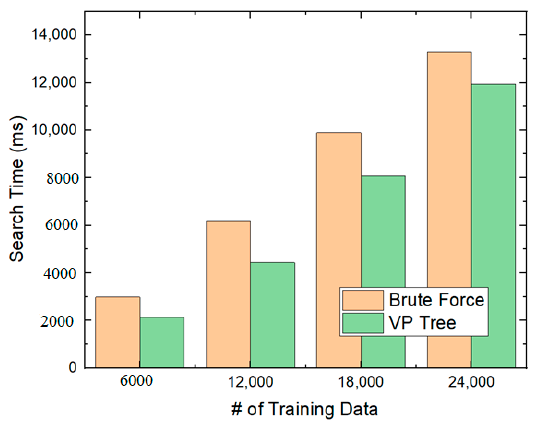
Figure 14. Search times. Figure 14. Search